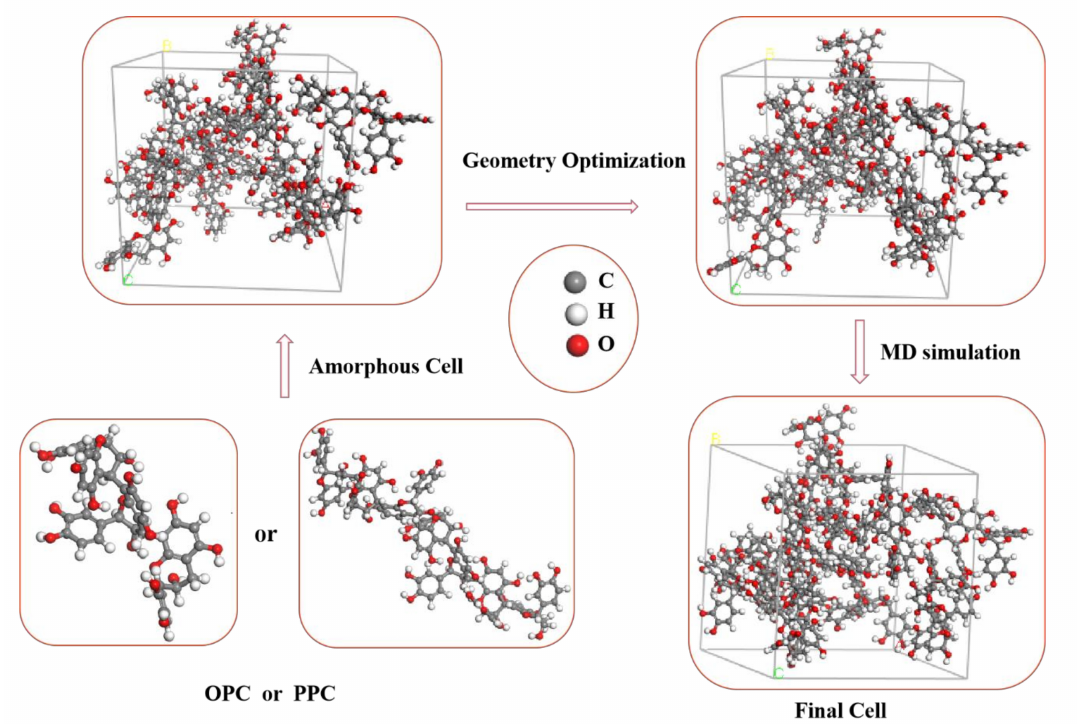
Figure 5. Flow chart showing molecular dynamics simulation (using trimer as an